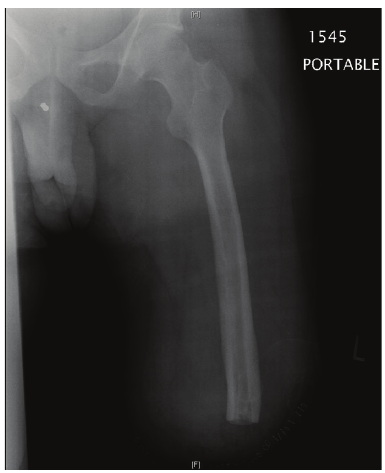
Figure 5: Left femur postamputation.